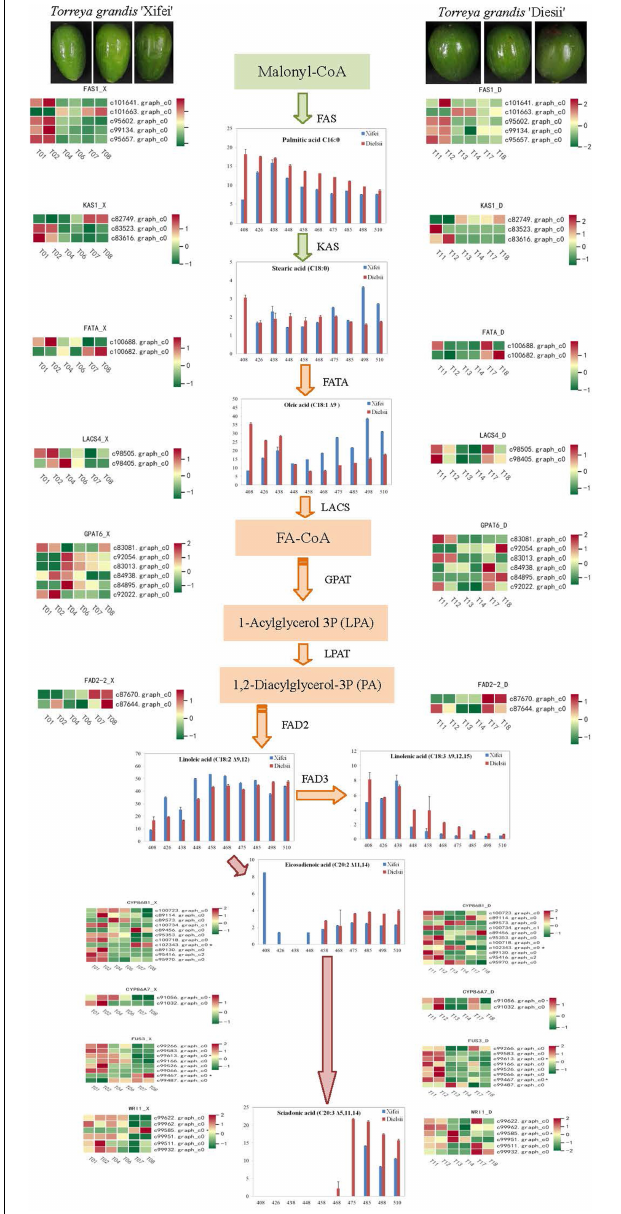
FIGURE 6 | Differential expression of unigenes associated with fatty acid biosynthesis with kernel development between T. grandis ‘Xifei’ (left) and T. grandis ‘Dielsii’ (right). Enzyme, unigene, and expression profiles are individually indicated at each primary step of biosyntheses. Colorful grids ranging from green to red in the row indicated the FPKM value of each unigene at the different development stages of kernels. Unigenes with significant correlation to C 20 : 3 FA were indicated with an asterisk (*) beside the sequence